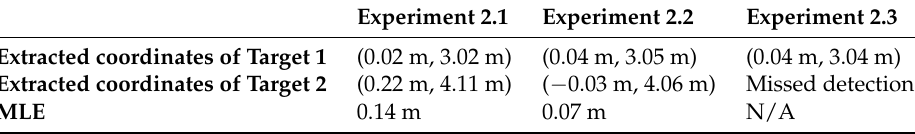
Figure 11. Photographs and geometries of Experiment 2. Table 3. Localization results and MLE of Experiment